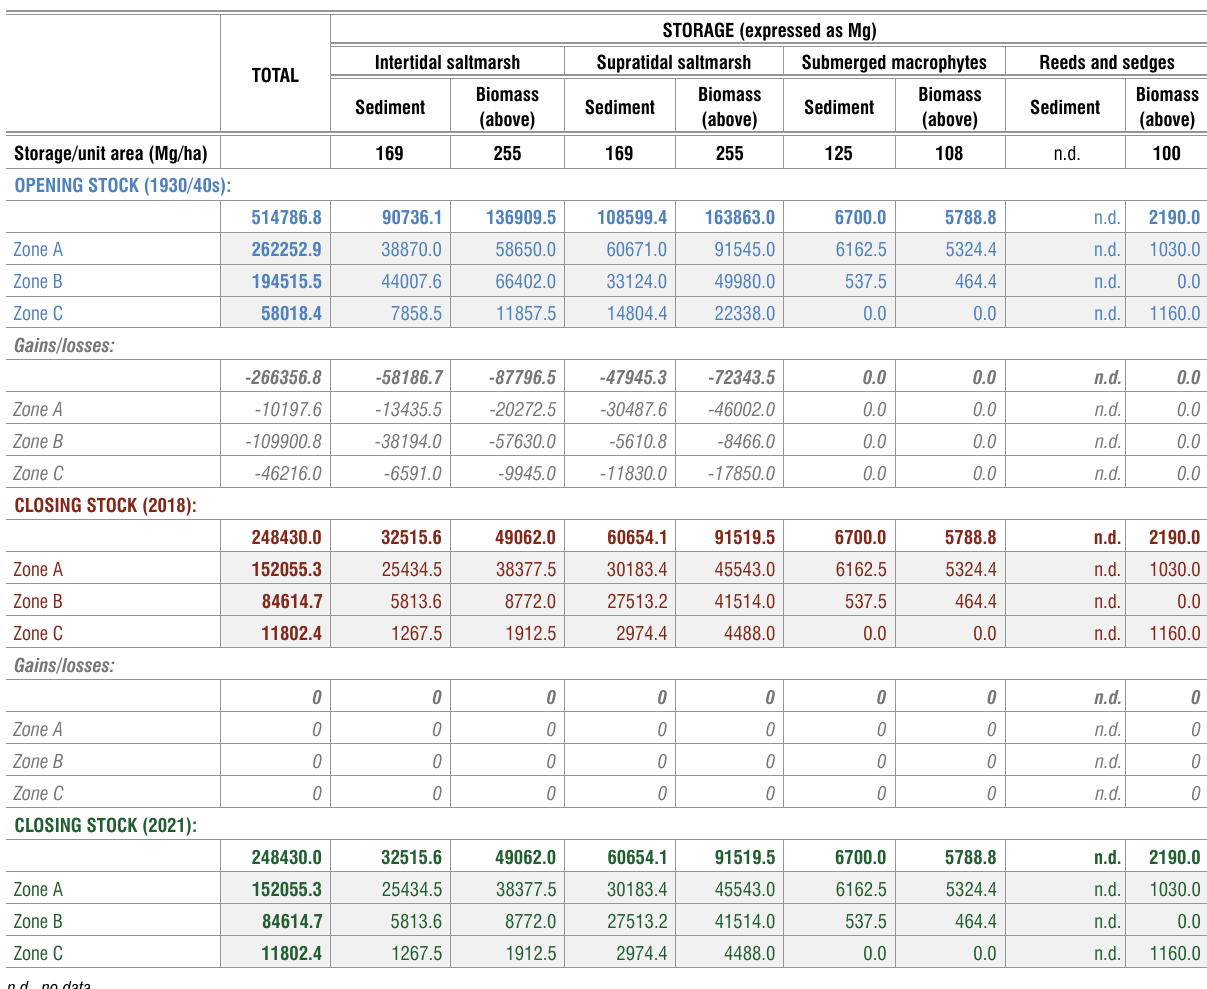
Table 7: Ecosystems services account for carbon sequestration potential in Swartkops Estuary